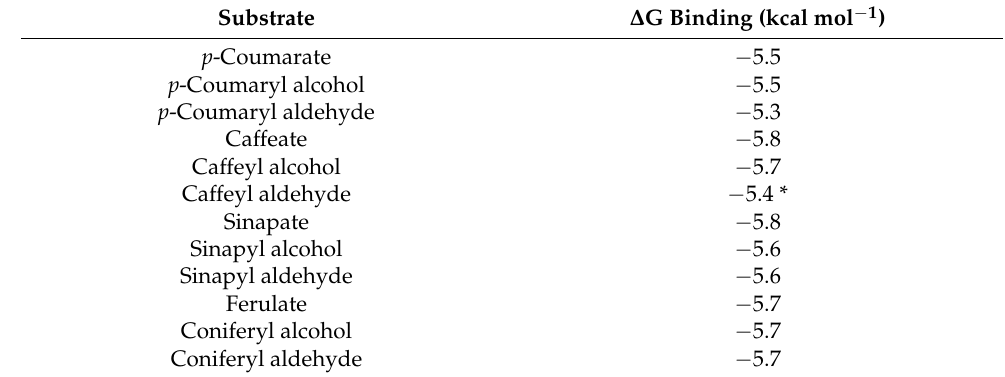
Table 2. Molecular docking energy of phenylpropanoid intermediates of the monolignol